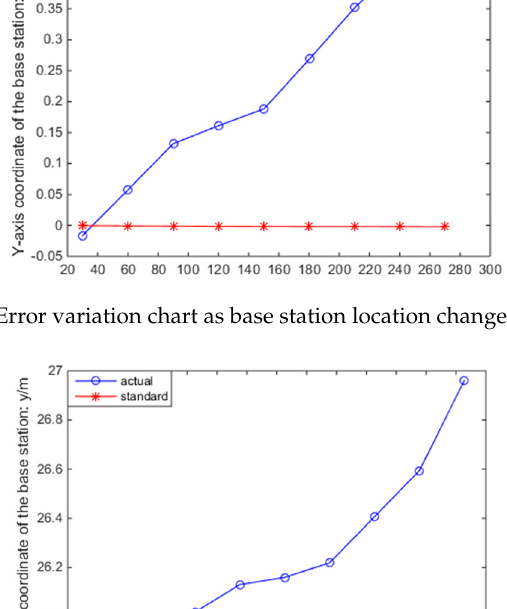
… Figure 12. Coordinate system for our semi-autonomous configuration technology. Compared with the manual operation configuration, the semi-autonomous configuration technology studied in this paper has greatly reduced the initial complexity and cost. Given that N base stations need to be configured in the scenario, N manual operations should be performed. However, if the whole network is divided into M segments, and using our algorithm, the number of operations is deduced to 2 × M + 2. Therefore, the cost and time consumed by our semi-autonomous configuration algorithm to manual operation is 𝐴 (cid:3015) = (cid:2870)×(cid:3014)(cid:2878)(cid:2870) (cid:3015) (𝑀 ≈ 𝑁 14(cid:3415) )